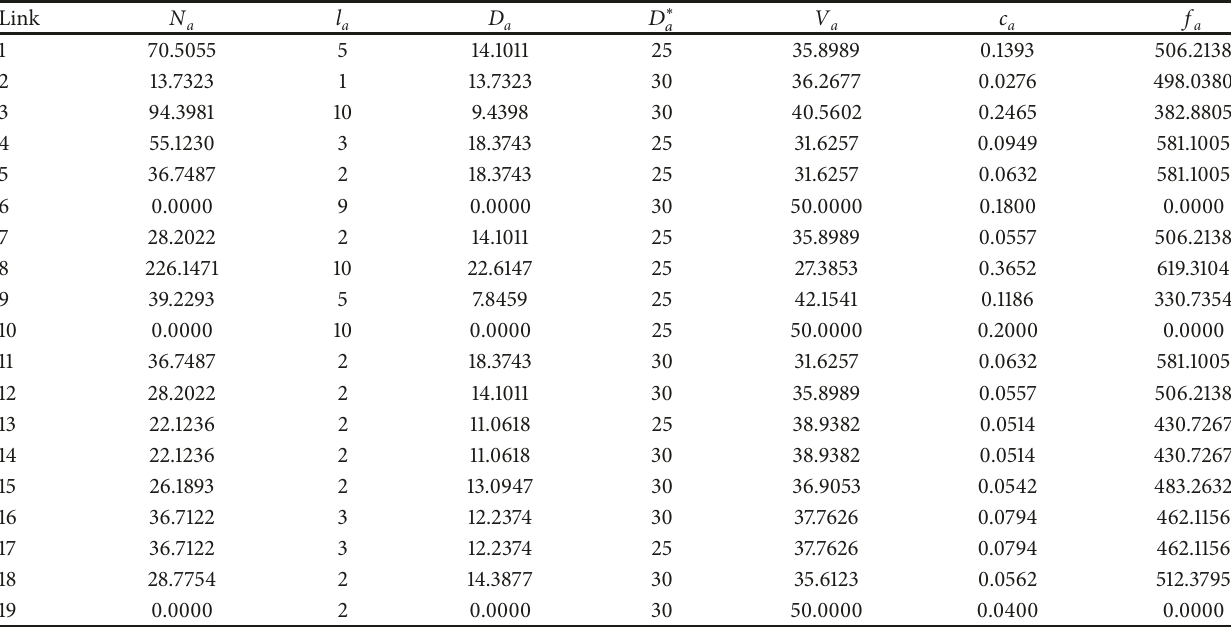
Table 6: Equilibrium Link Assignments, Density-Based Approach (low congestion).